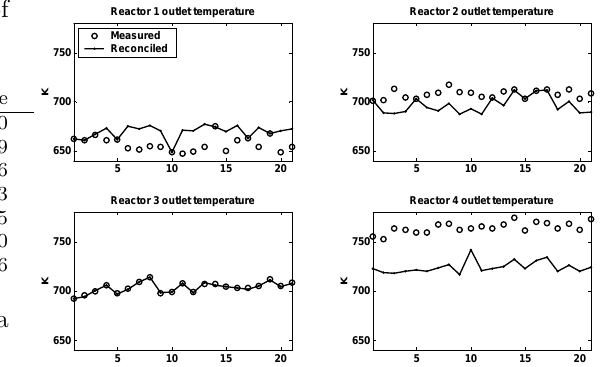
Figure 5: Reconciled reactor outlet temperatures for the 21 data